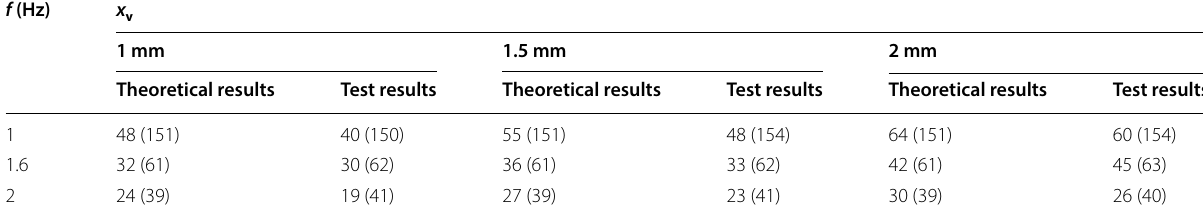
( L ) ( p 1 MPa) 0max s =